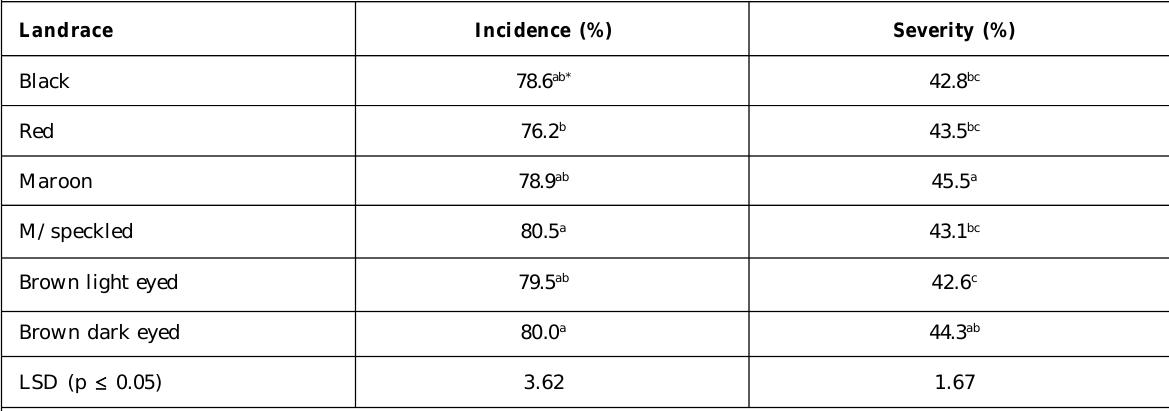
Table 2: ANOVA for Fusarium wilt incidence and severity among selected Bambara nut landraces Source